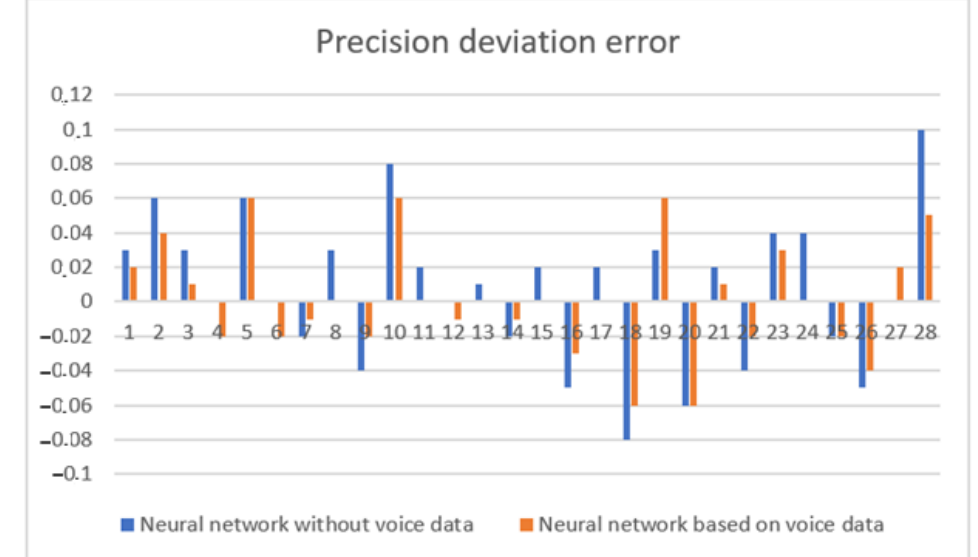
Figure 7. Estimates of the condition of patients.